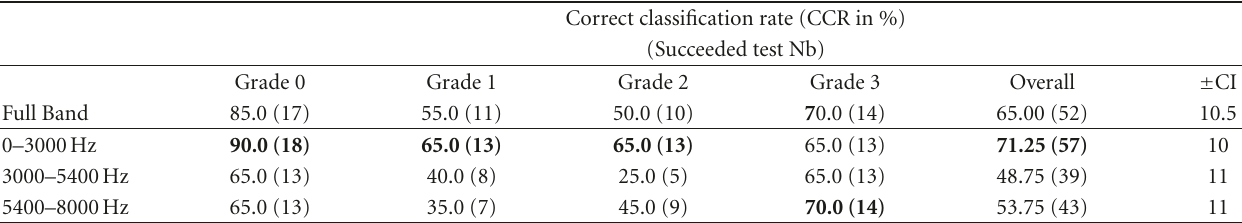
Table 3: Performance of the 4-G classification following joint frequency subbands in terms of correct classification rates (% CCR)—24 LFSC. Confidence intervals (CI) are provided for the overall scores.